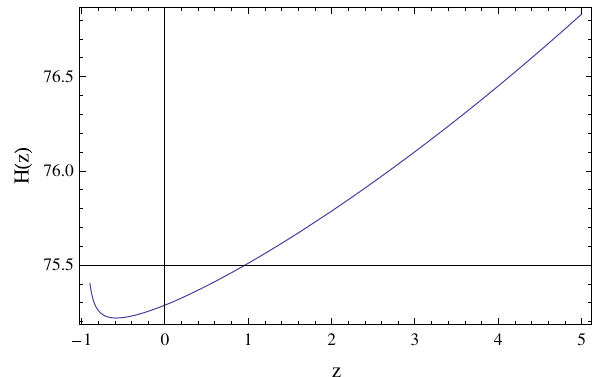
Fig. 29 Variation of φ( z ) with the variation of z (Model IV) by con- sidering the best fit values w 0 = − 0 . 766 ,w 1 = 0 . 307